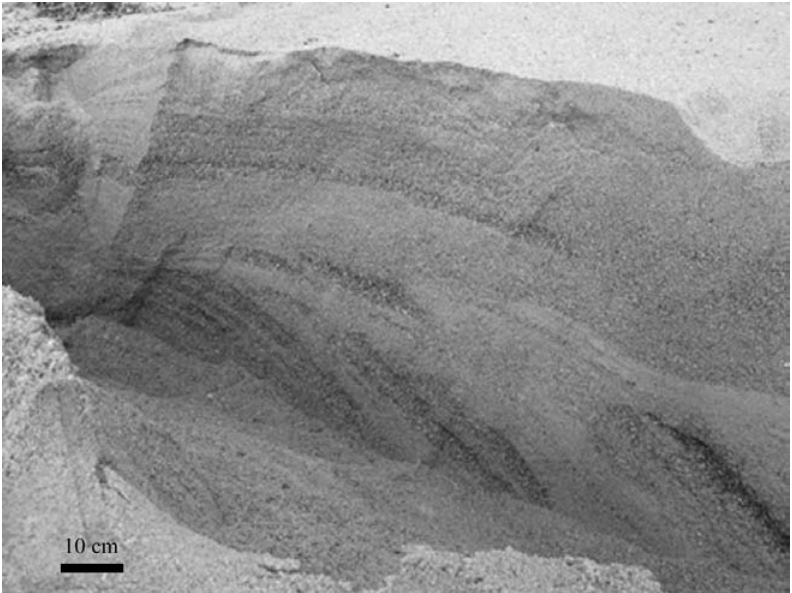
Fig. 2b – Internal sedimentary structures within the crest of the beach ridge shown in figure 2a. All sediments are wave deposited backset, topset and foreset beds formed during high water level swash